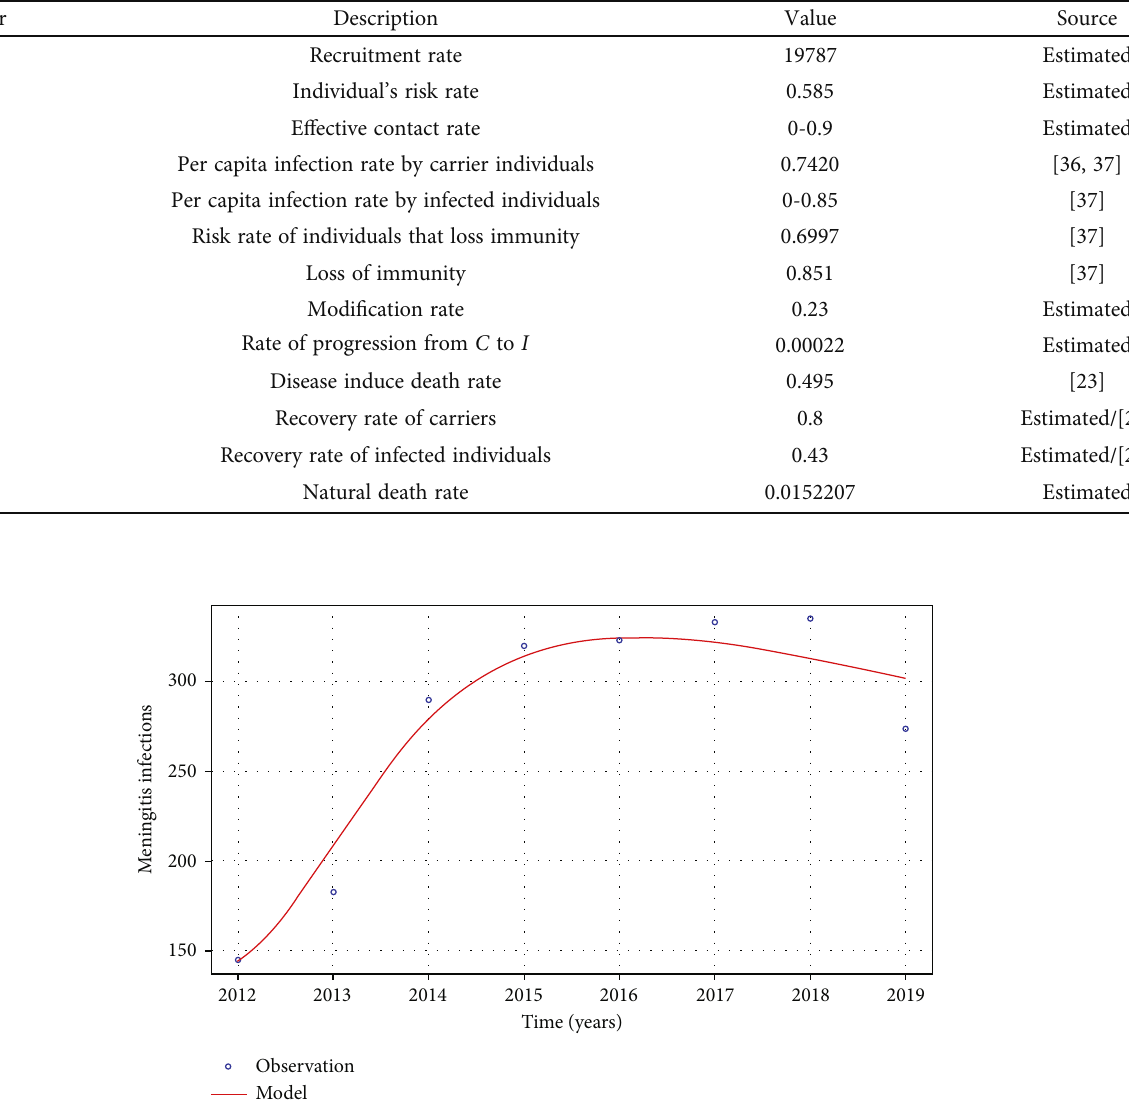
Figure 5: Fitted model of system (2) using the Nelder-Mead optimization approach. The least-squares regression or Nelder-Mead approach minimizes the mean of squared error (MSE) between the prediction states and their observation values from the